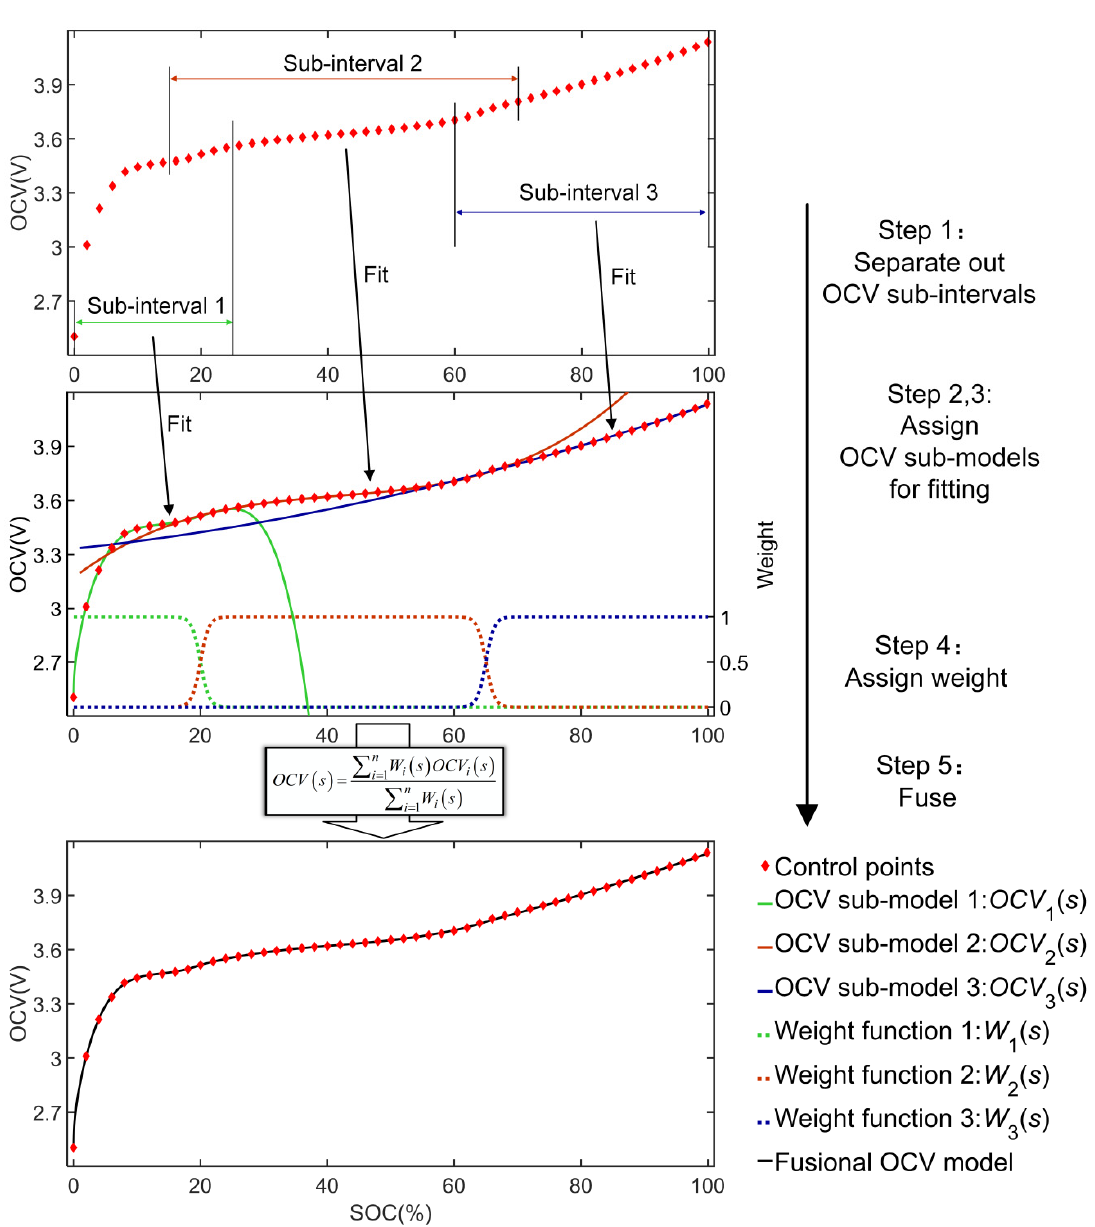
Figure 3. Flowchart of OCV model fusion method.